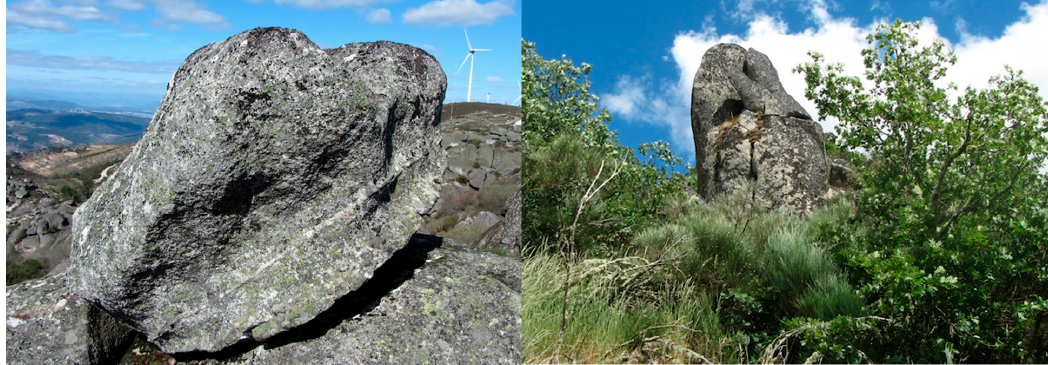
Figure 3. Tafone sketch in lateral wall and base. Please note the presence a quartz intrusion ( left ). Tafone sketches in lateral wall ( right ).